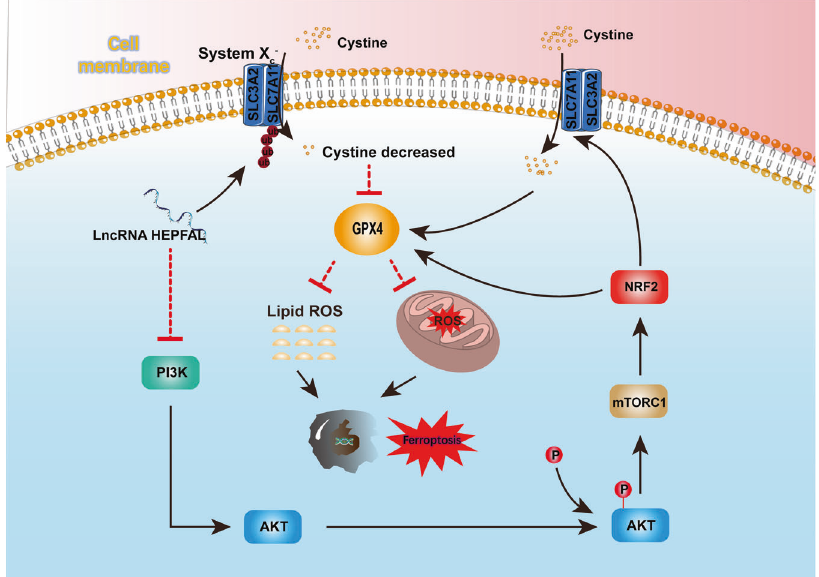
Fig. 8 LncRNA HEPFAl promotes ferroptosis by modifying SLC7A11 ubiquitination. Working model for lncRNA HEPFAL in cell